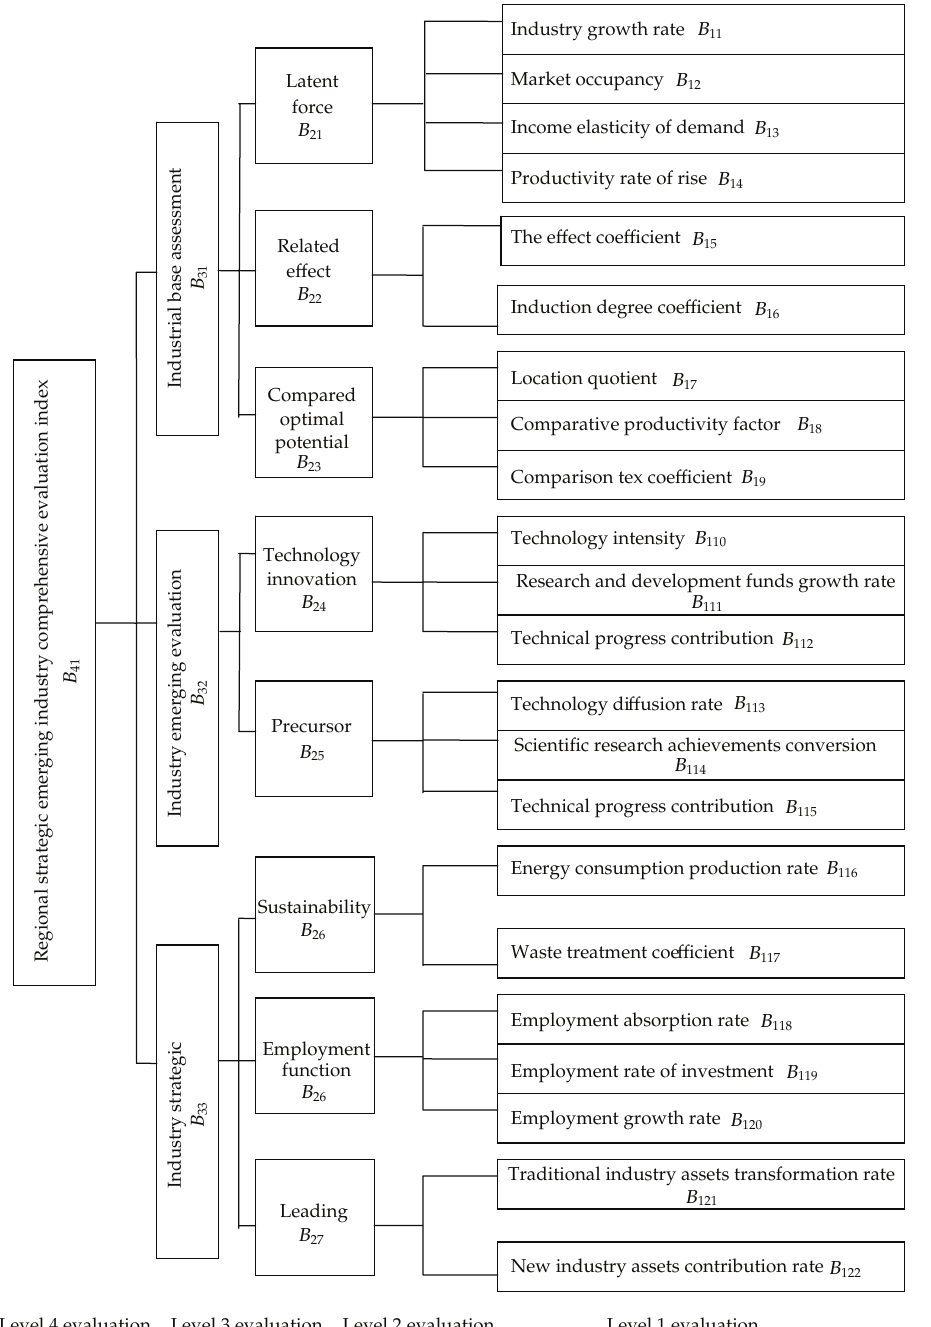
Figure 1: Index system of regional strategic emerging